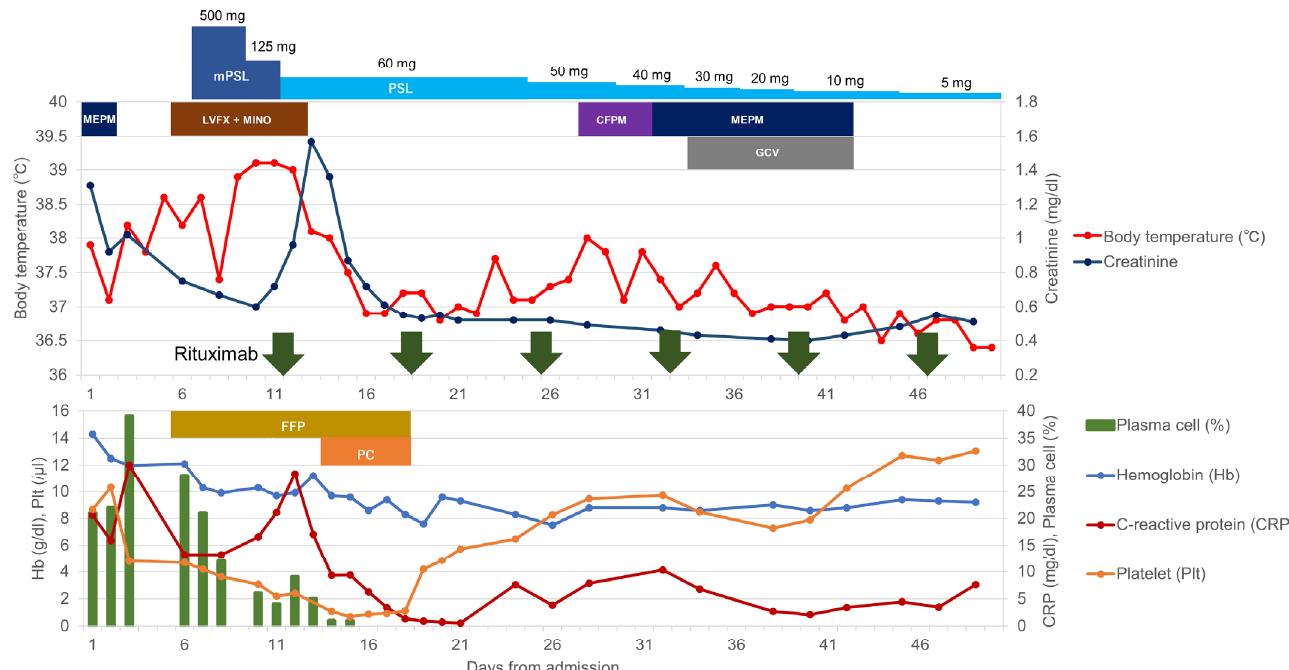
Figure 6. Clinical course from patient admission to discharge. Abbreviations: CFPM, cefepime; DOB, dobutamine; FFP, fresh-frozen plasma; GCV, ganciclovir; LVFX, levofloxacin; MINO, minocycline; mPSL, methyl prednisolone; MEPM, meropenem; NAD, noradrenaline; PC, platelet concentrate; PSL, prednisolone.